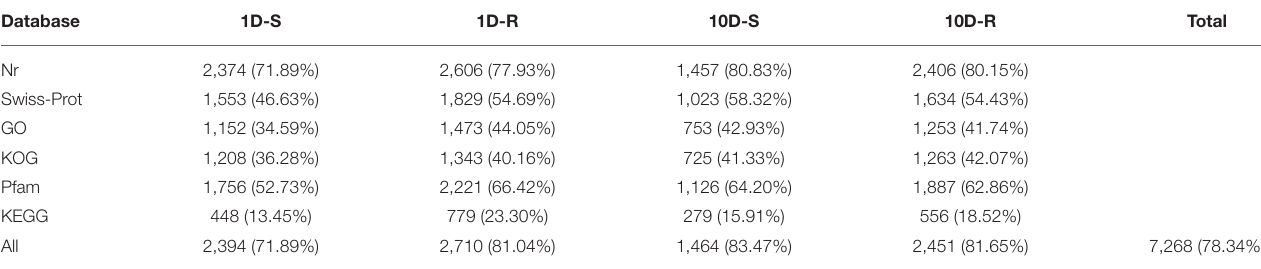
TABLE 3 | Summary of DEGs annotation (number).